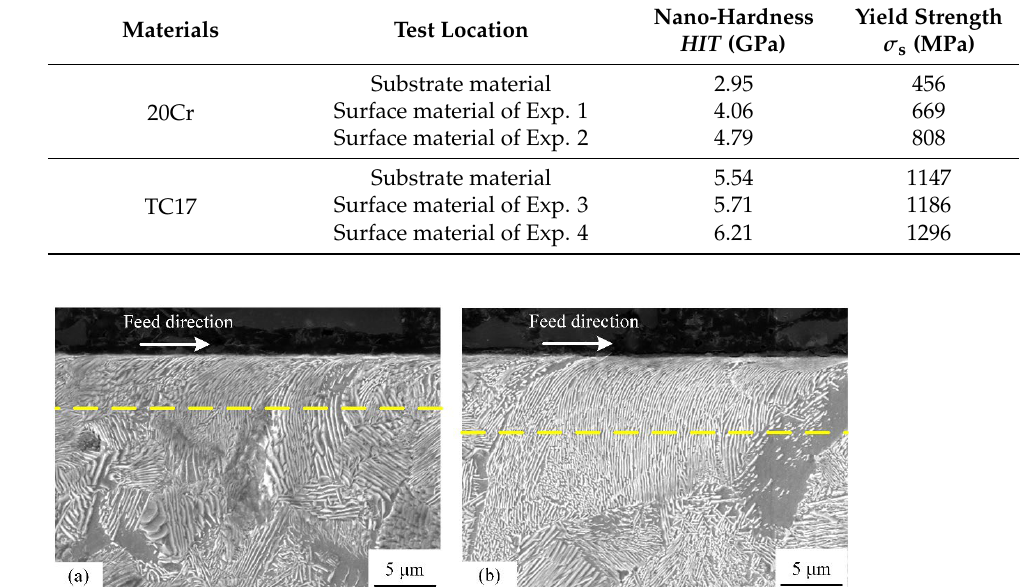
Table 7. Calculated yield strength of 20Cr and TC17 specimens.